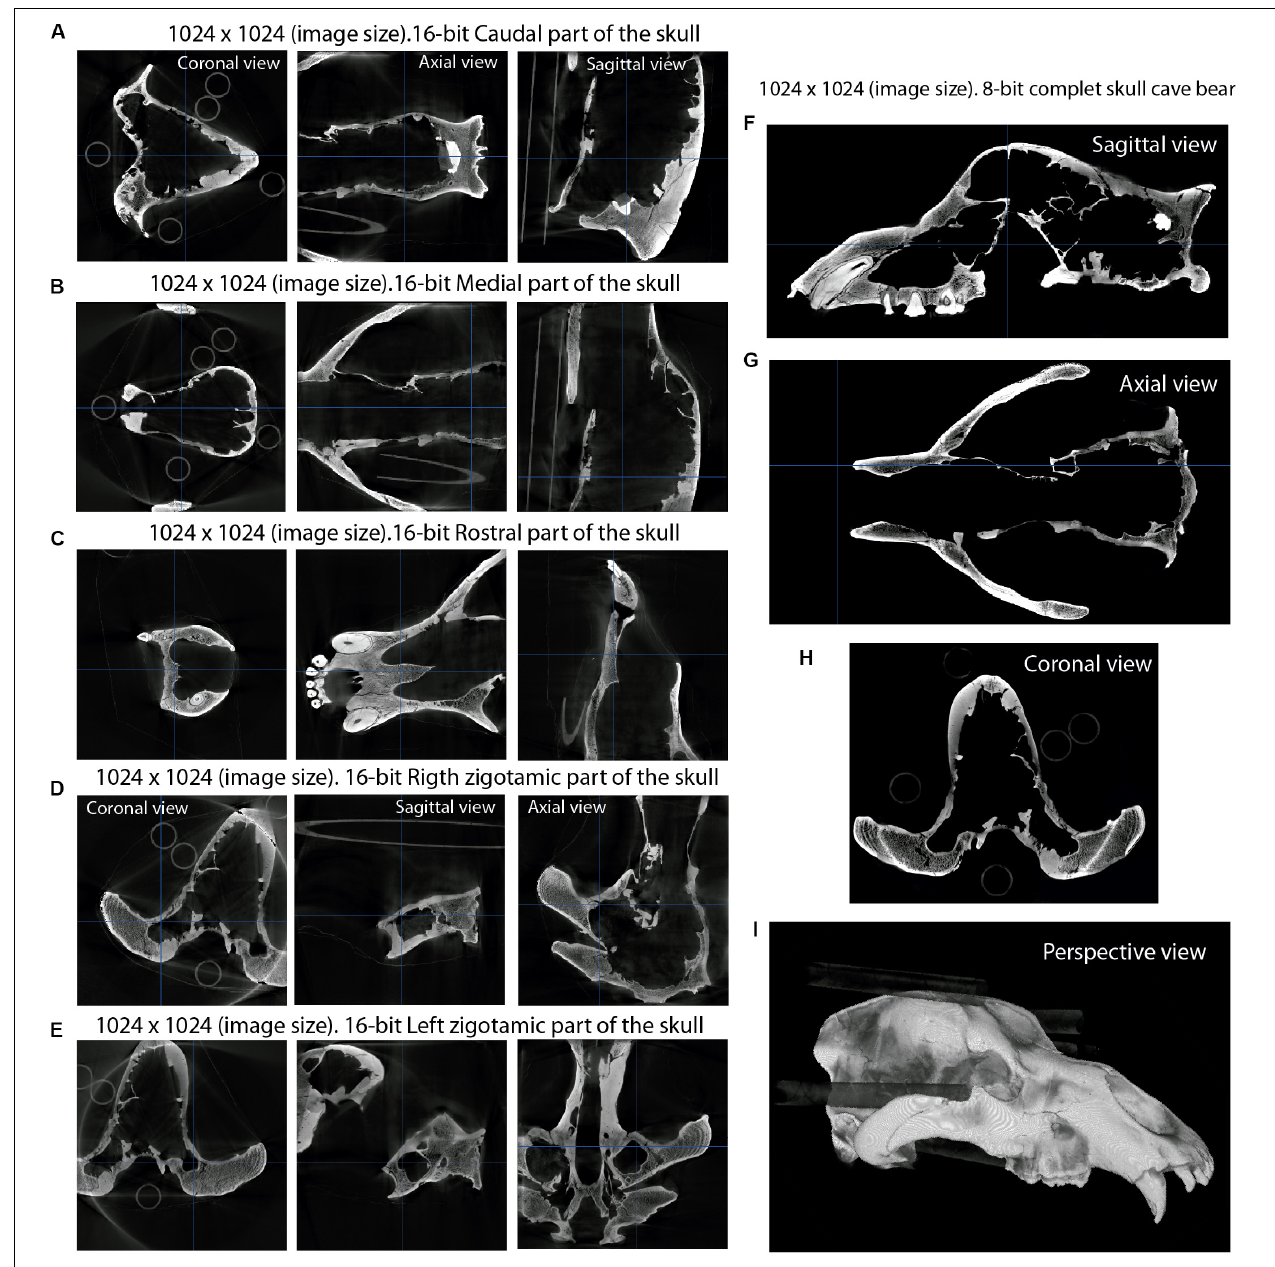
FIGURE 4 | Digital process of fitting different image stacks to the same orientation, using the reslice function in ImageJ (Rueden et al., 2017) on the cave bear skull ( U. spelaeus spp.). (A) Image stack of the caudal part. (B) Image stack of the medial part. (C) Image stack of the frontal part. (D) Image stack of the right zygomatic arch. (E) Image stack of the left zygomatic arch. (F–H) Result of the concatenation and reslicing showing the skull in sagittal (F) , axial (G) , and coronal (H) views. (I) perspective view of the fitted object “3D rendering window.”